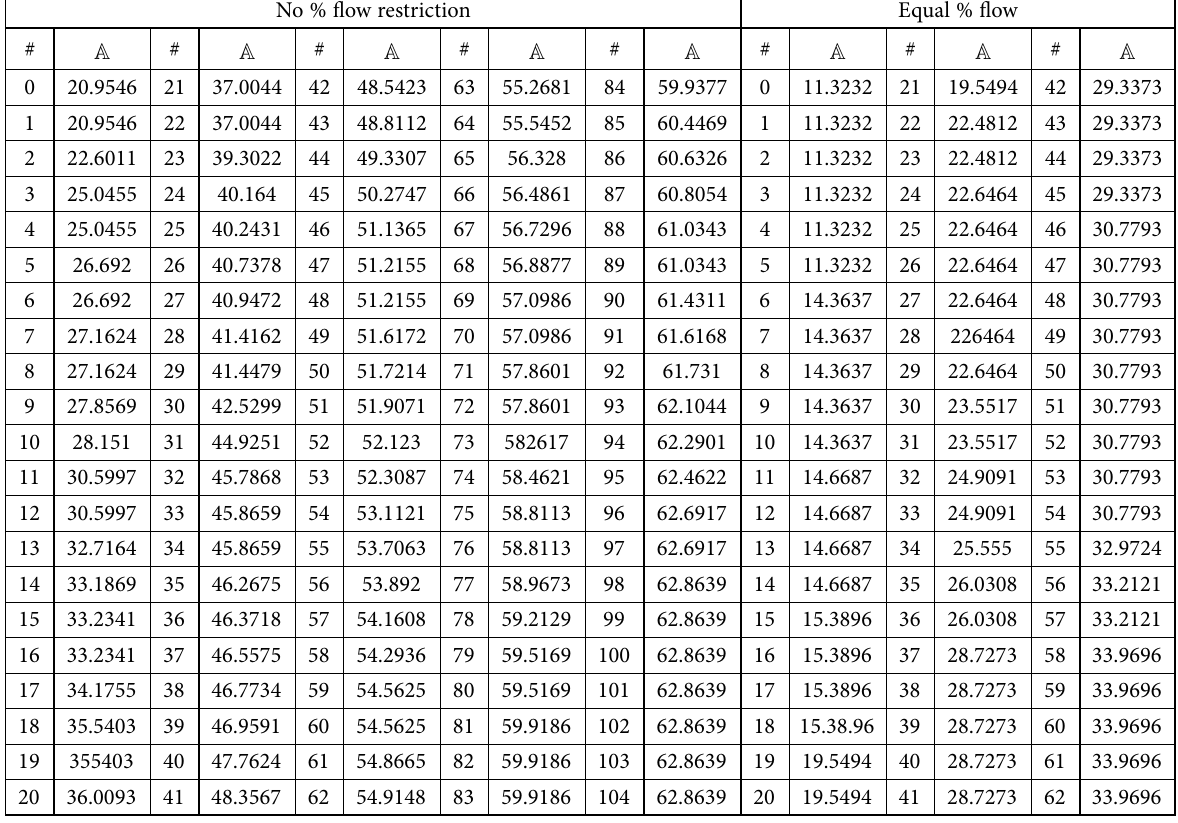
Table 13. Absolute capacity for incrementasl budget changes